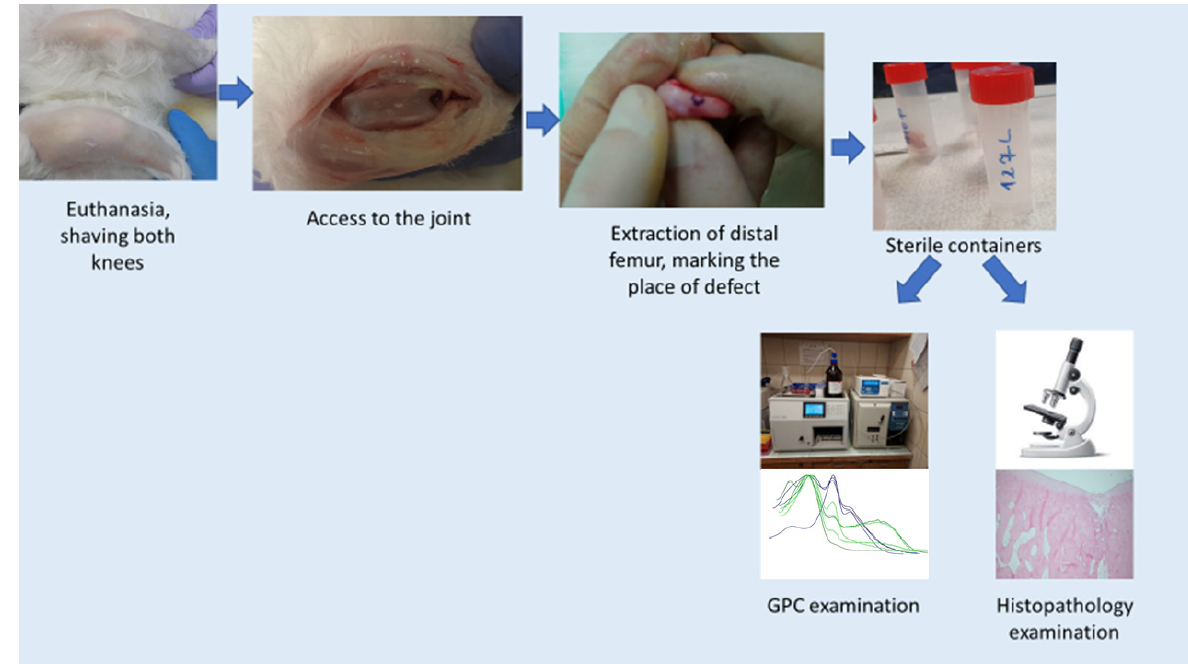
Figure 4. Termination scheme.